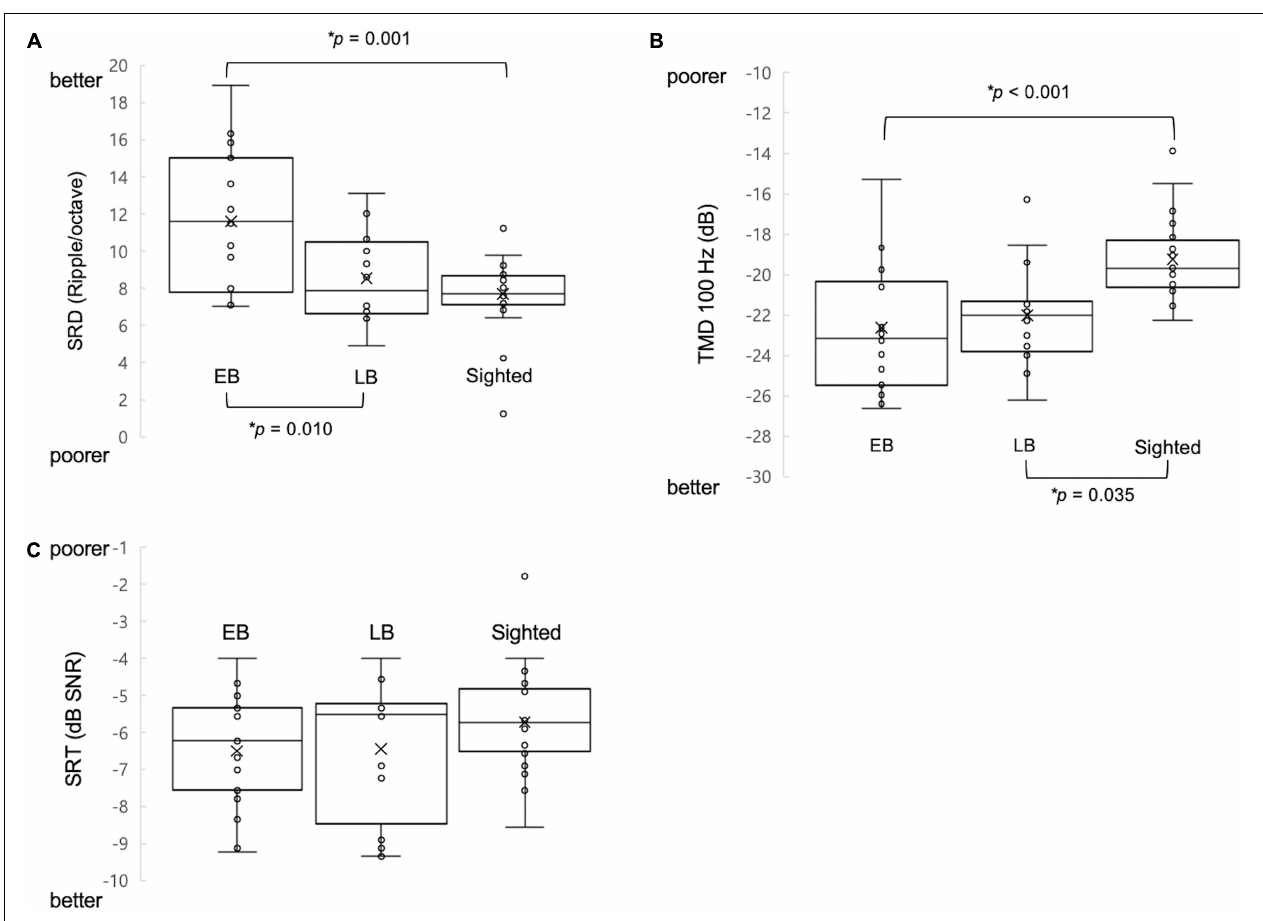
FIGURE 2 | Comparison of three measures of psychoacoustic performance and acoustic change complex (ACC) among early blind (EB), late blind (LB), and sighted subjects. (A) The spectral-ripple discrimination (SRD) threshold was greater in EB subjects (i.e., better SRD) than in LB and sighted subjects. (B) The temporal modulation detection (TMD) threshold was lower (i.e., better TMD) in EB subjects and in LB subjects compared with sighted subjects. (C) The speech reception thresholds (SRTs) in noise were not significantly different among the three groups of subjects. ∗ Significantly different between the indicated groups ( p < 0.05).